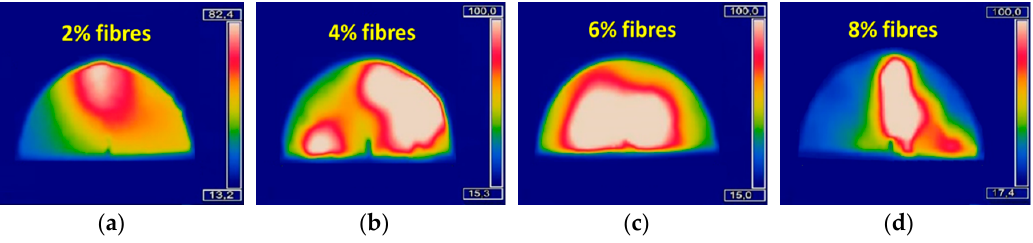
Figure 4. Thermographic images of asphalt mixtures with different fibre content after 40 s of microwave heating: mixtures with ( a ) 2%; ( b ) 4%; ( c ) 6%;( d ) 8% of steel wool fibres.